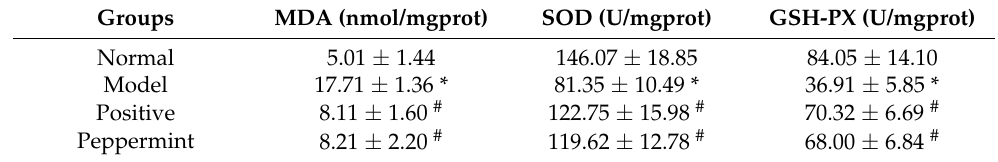
Table 4. Levels of oxidative stress factors in brain tissues of each group of mice (x ± S, n = 8). Groups MDA (nmol/mgprot) SOD (U/mgprot)